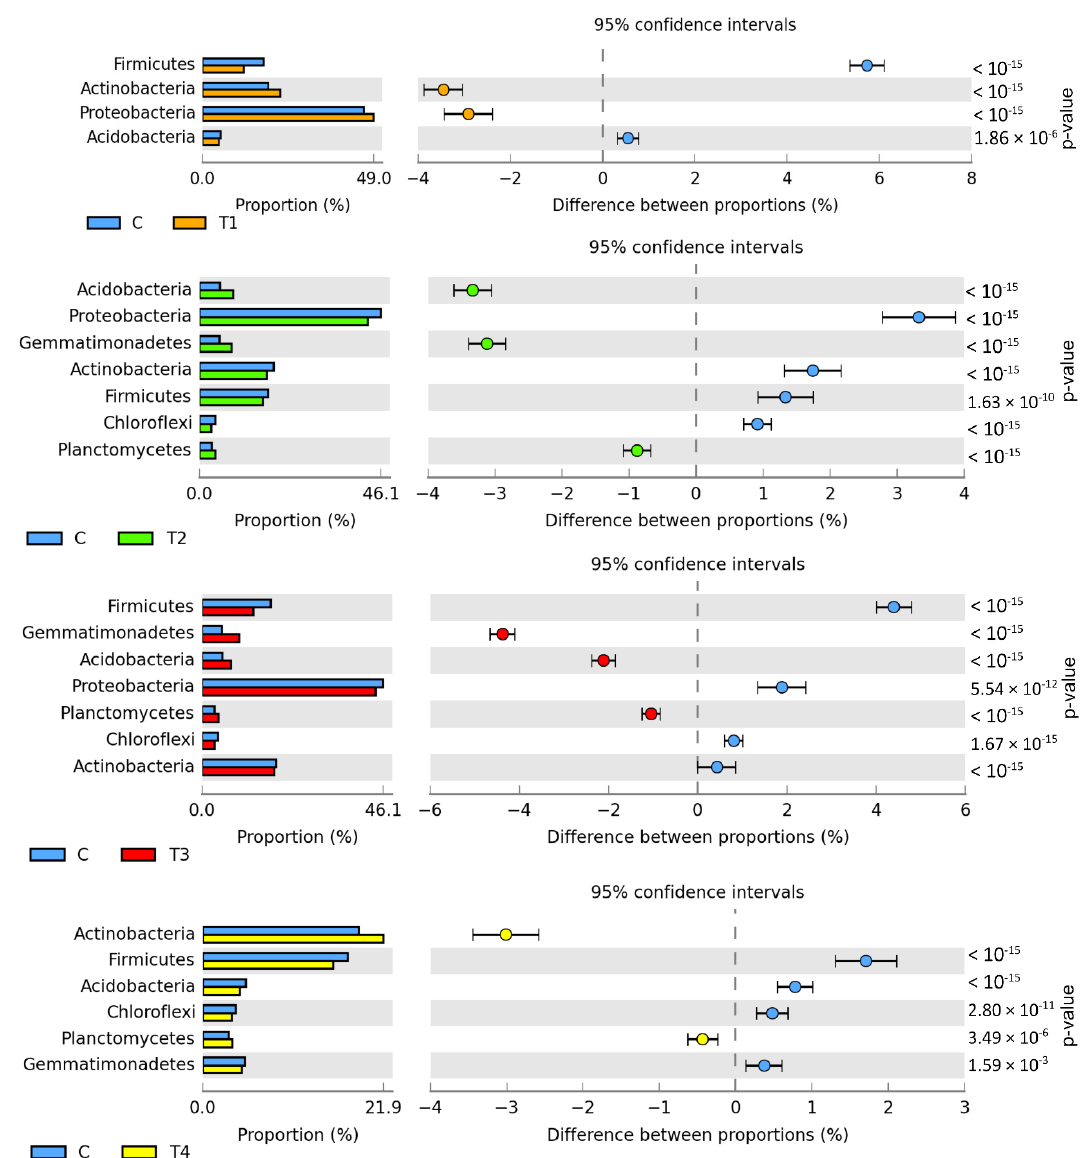
Figure 1. Differences between ratios of bacterial phyla, OTU ≥ 1%. Tebuconazole doses in mg kg − 1